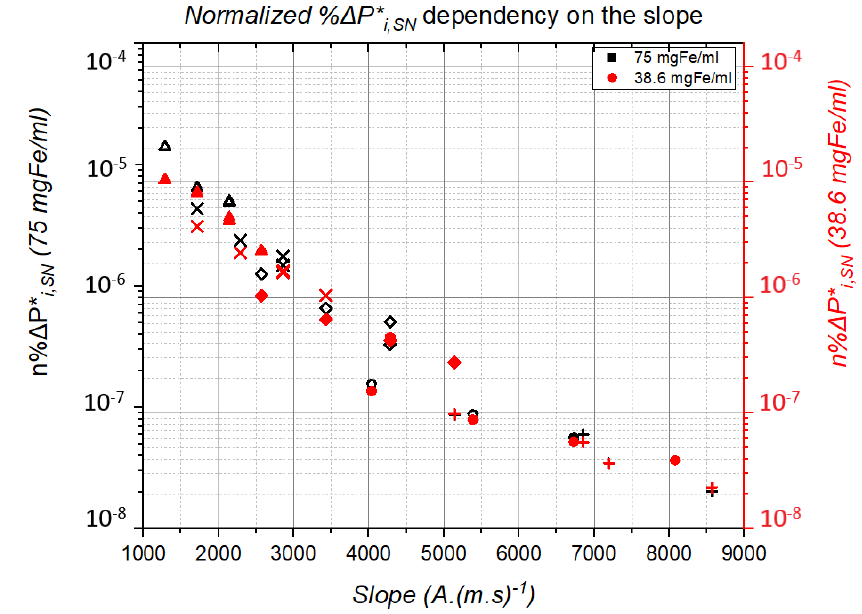
Figure 13. Normalized % ∆ P ∗